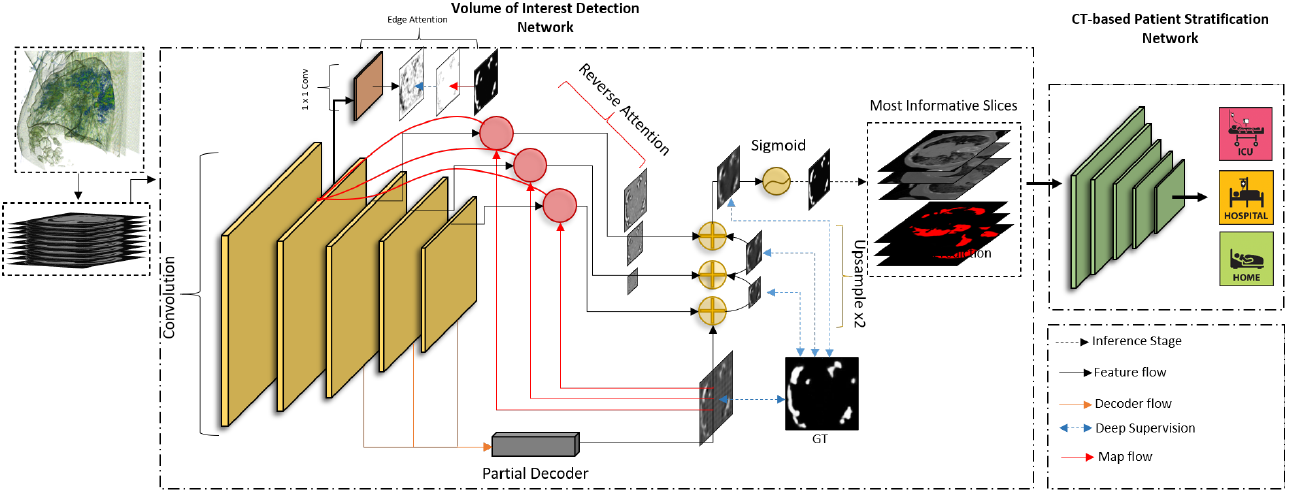
Figure 3. Overview of the suggested two-stage approach composed of our volume-of-interest (VoI) detection through lesion segmentation to quantify Coronavirus Disease 2019 (COVID-19) infection on the various 3D segments of the lung CT, and patient stratification through VoI classification